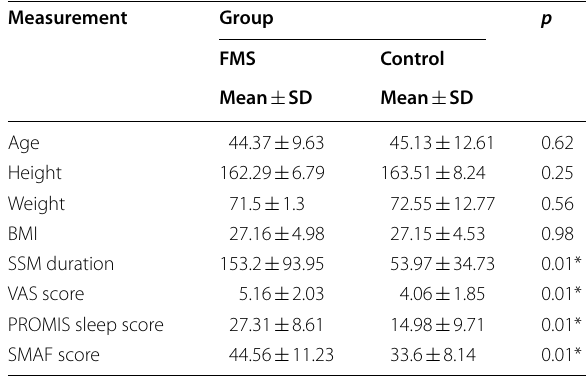
Table 3 Analysis of patient measurements according to